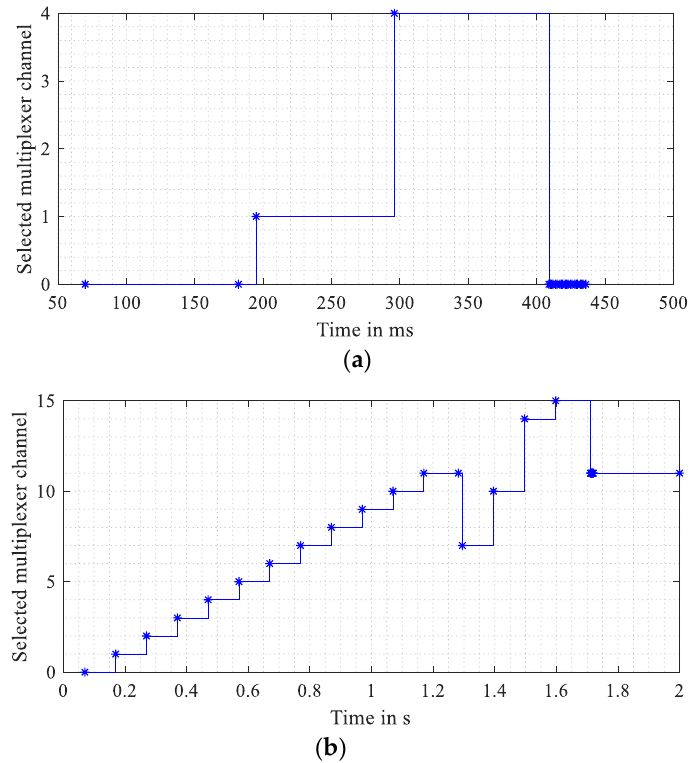
Figure 23. Multiplexer channels during the scanning phase ( a ) No receiving device is present ( b ) WSN on the top of C0.